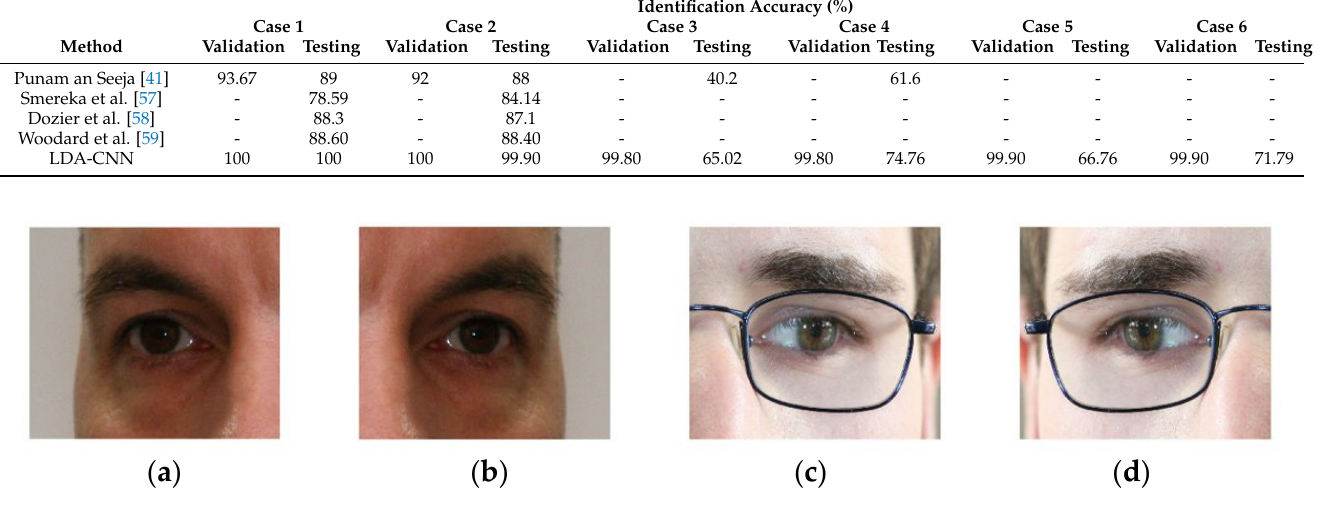
Figure 10. An example of left and right periocular images along with their mirror images from UBIPr dataset. ( a ) Left image; ( b ) Left mirror image; ( c ) Right image; ( d ) Right mirror image.